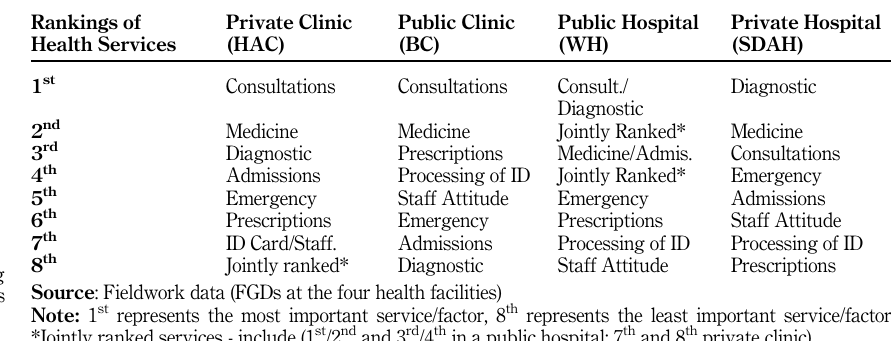
Table 5. Summary